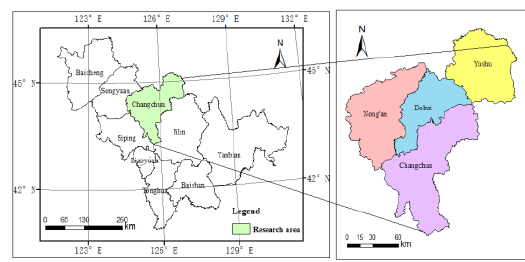
Figure 1. Geographical location of the study area